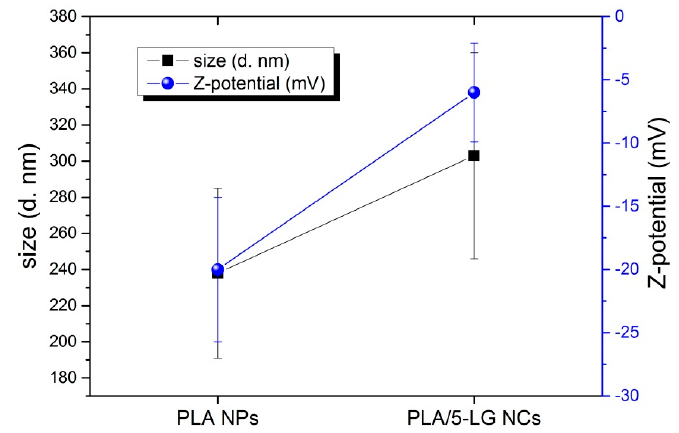
Figure 2. Dynamic light scattering (DLS) analysis revealing the size and Z-potential of PLA NPs and PLA/5-LG NCs.